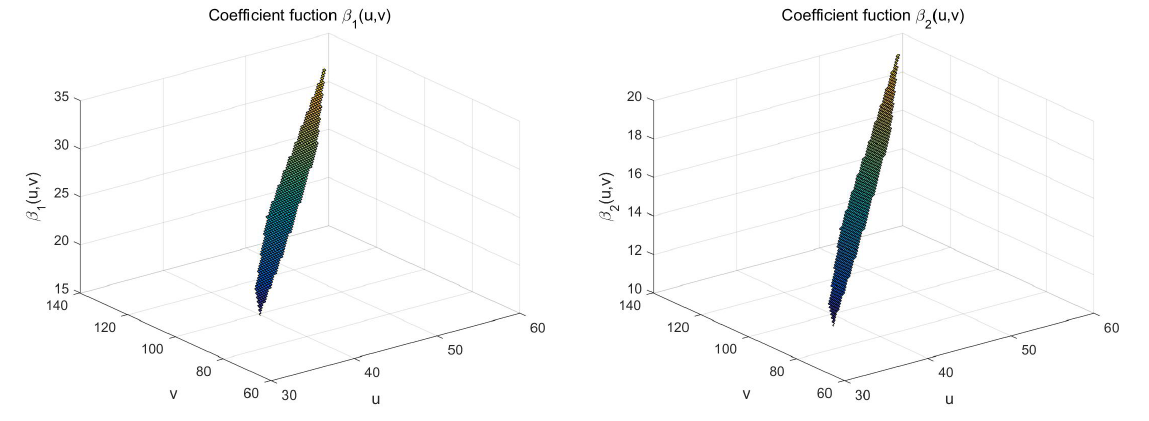
Figure 1. The real surface of the coefficient function β 1 ( u , v ) ( left ) and β 2 ( u , v ) ( right